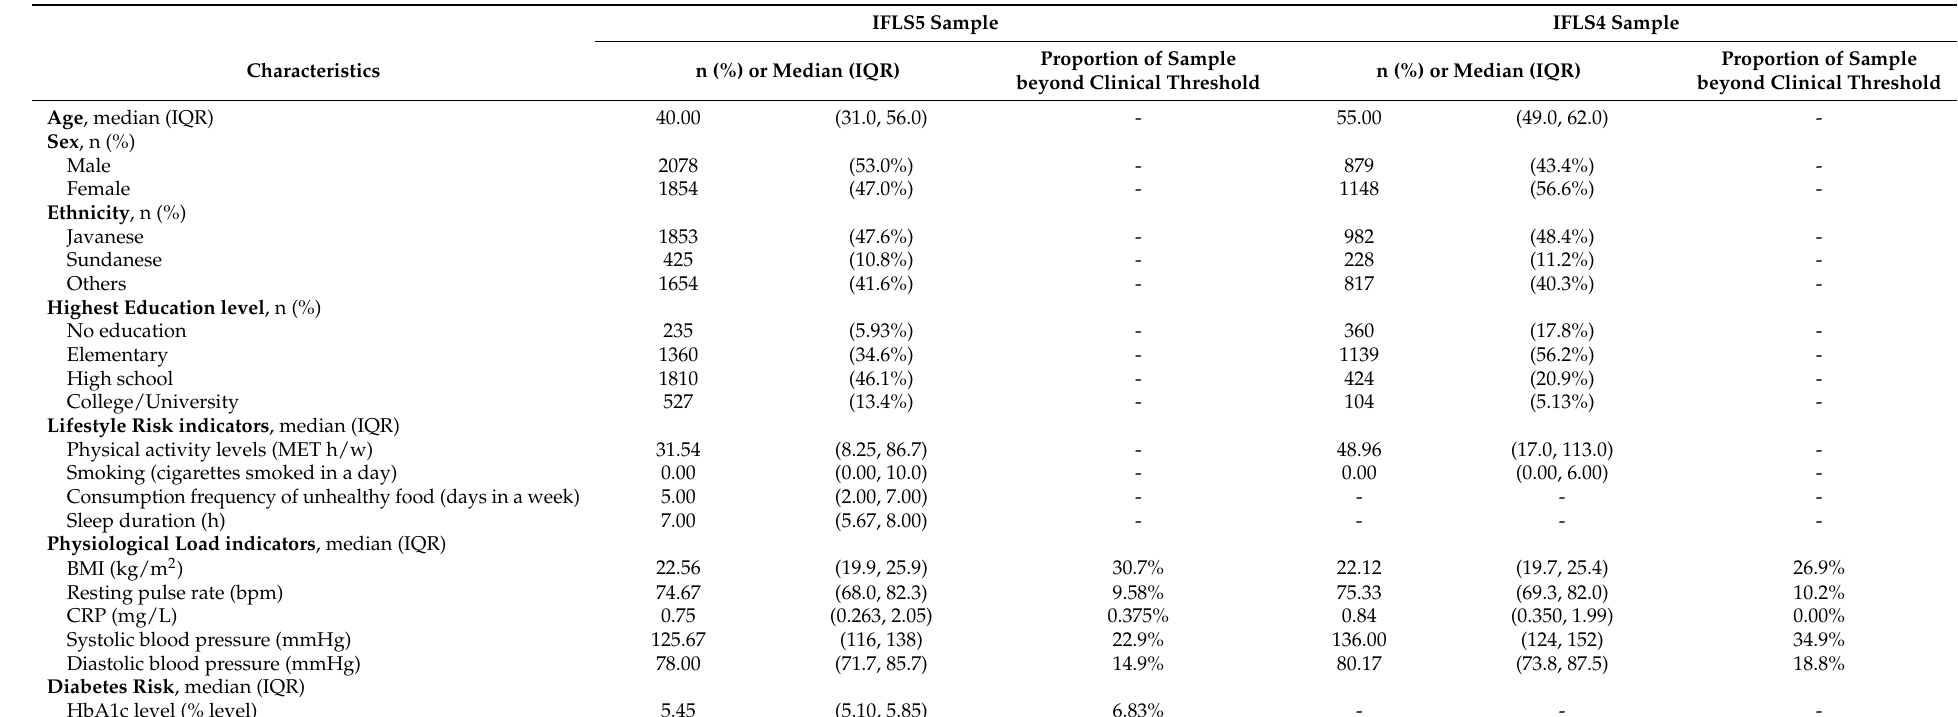
Table 1. Sociodemographic, lifestyle and physiological